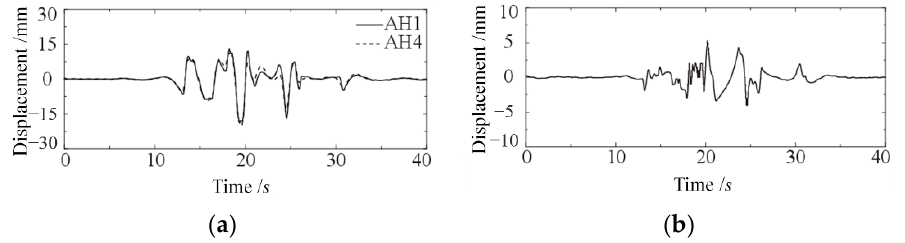
Figure 11. The displacement response at AH1 and AH4: ( a ) displacement time history; ( b ) displacement difference time history.